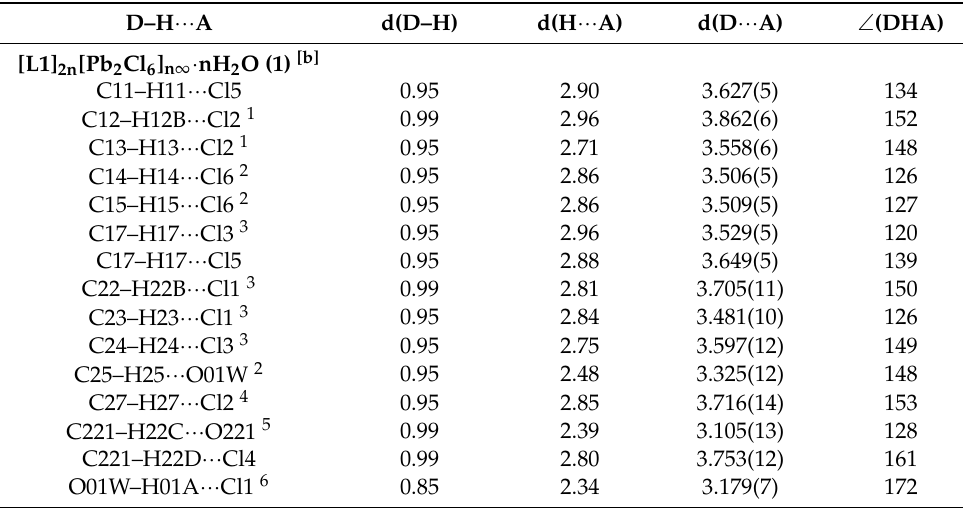
Figure 2. ( a ) Fragment of the 1D twin offset chloroplumbate(II) chain in 1 . The symmetry codes have the same numbering as those in Table 2; ( b ) polyhedral representation of the same fragment; the inset shows a common type of edge-sharing within a double haloplumbate(II)wire; ( c ) fragment of the crystal packing of 1 demonstrating spatial arrangement of the organic and inorganic counterparts (the major component of the disordered (N22, N23A) cation is shown). Table 3. Geometry of hydrogen bonds for 1 − 3 (Å and ◦ ) [a] Table 2. Selected bond lengths (Å ) and angles (°) in 1 − 3 [a] .